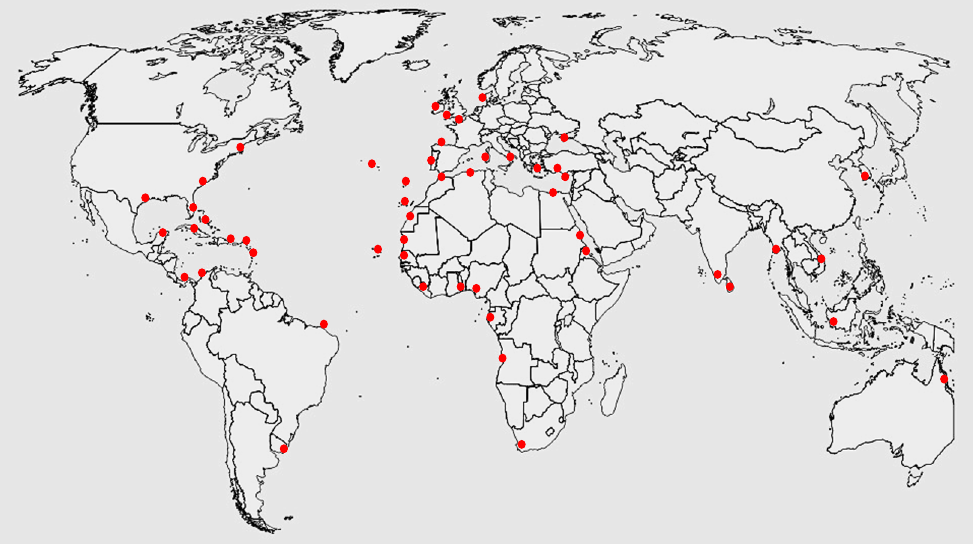
Figure 2. World distribution of Gelidium corneum (data from Guiry [72]).